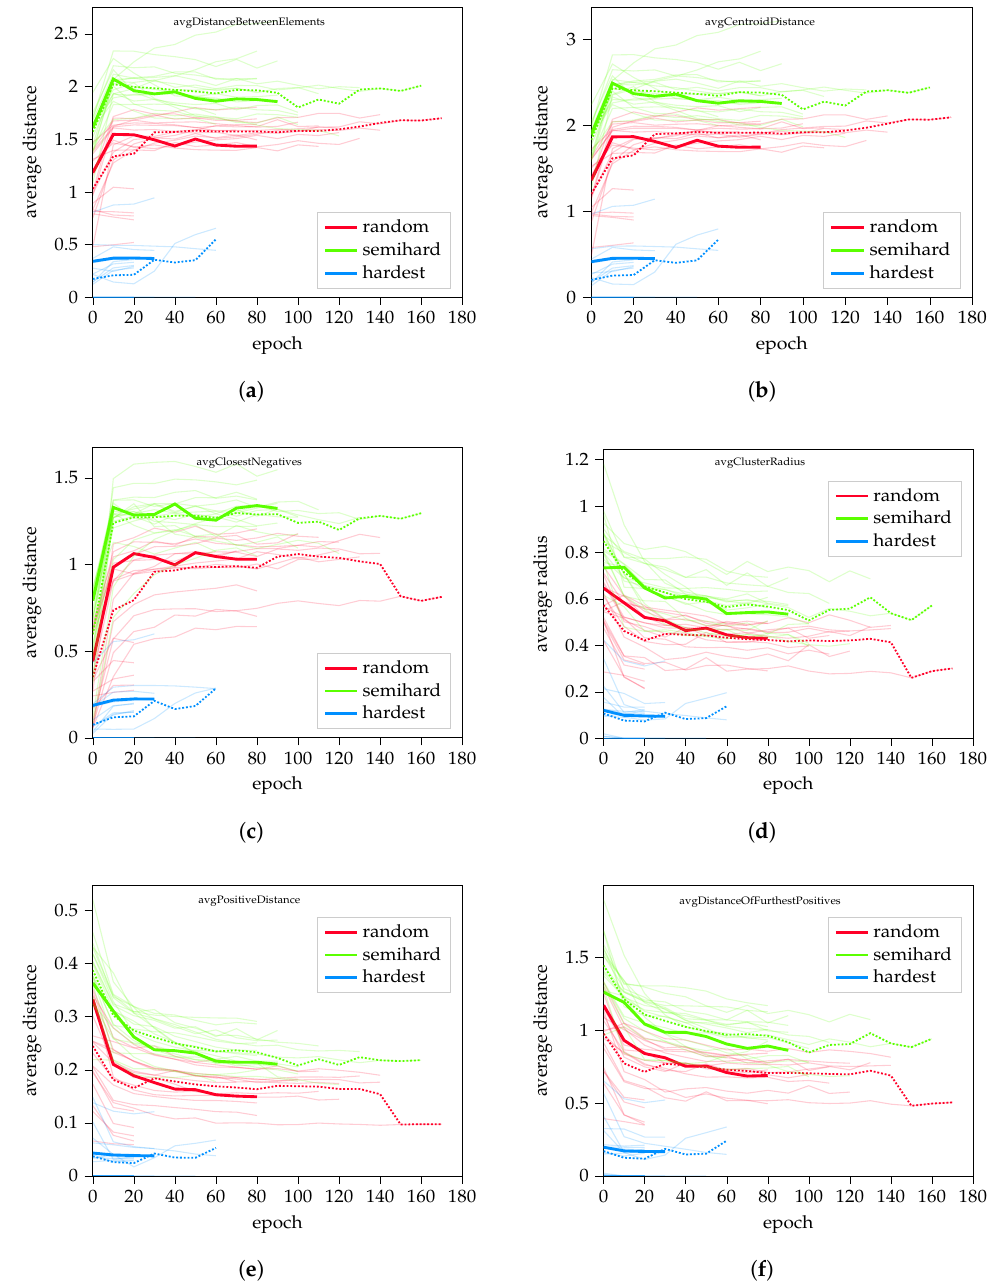
Figure A1. Cluster analysis results for random hard, semi-hard, and hardest negative mining. Sub- figures show ( a ) the dynamic of average element distance, ( b ) average centroid distance, ( c ) average distance of closest negatives, ( d ) average length of cluster radius, ( e ) the average distance between positive pairs, and ( f ) the average distance of furthest positives,